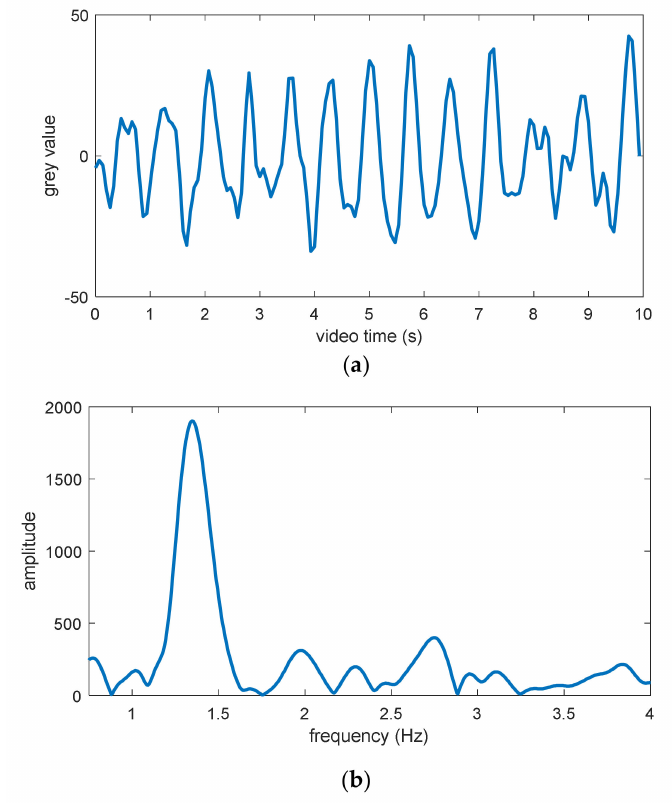
Figure 10. Estimation of one heart rate: ( a ) Final PPG signal, ( b ) power density spectrum calculated from the final PPG